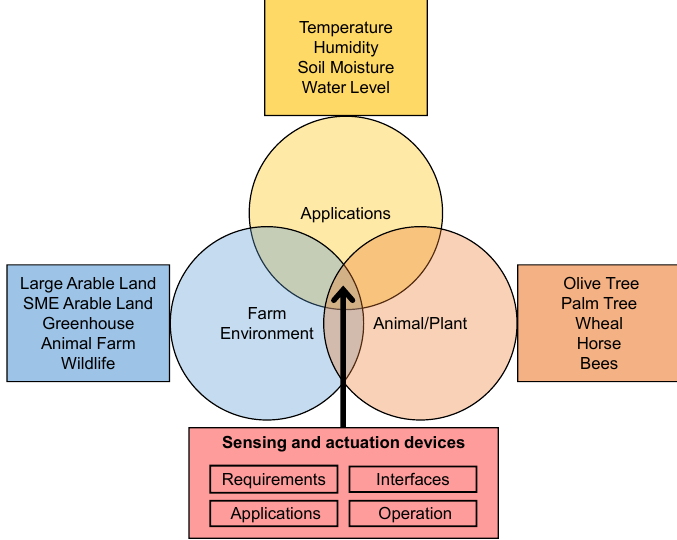
Figure 2. Process of identifying the measurement parameters